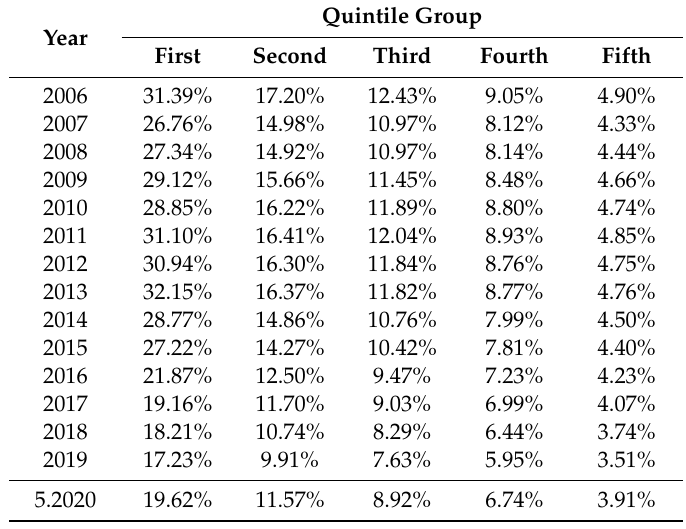
Table 5. Proportion of expenditure on energy carriers in disposable income by quintile